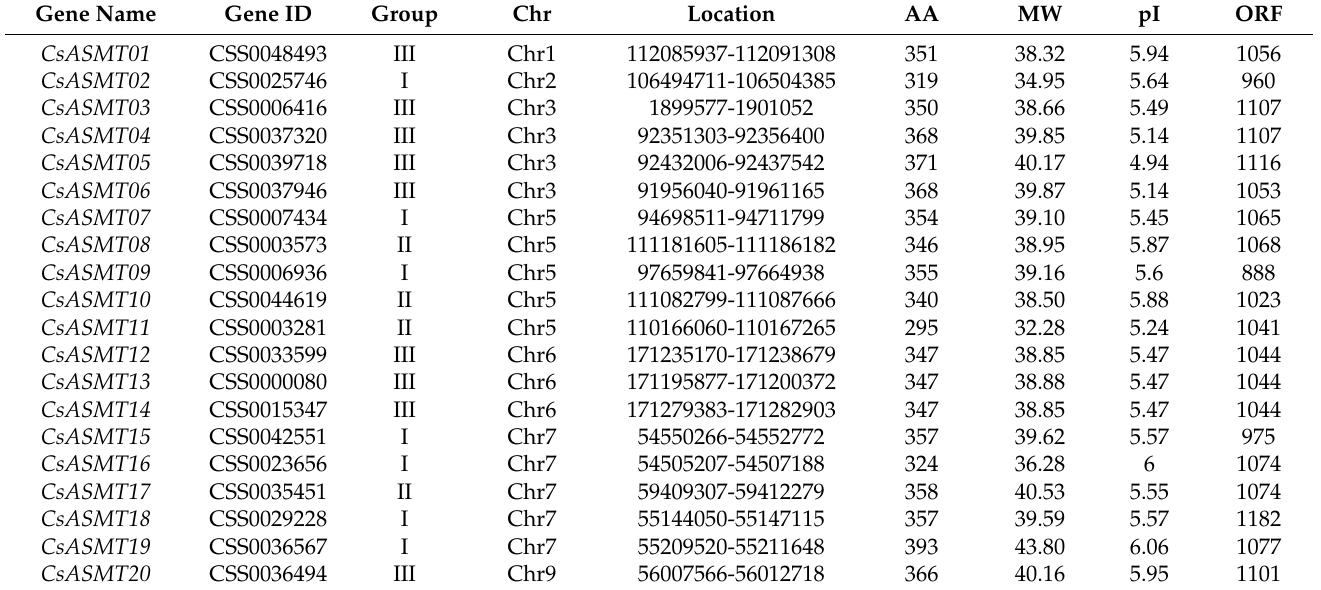
Table 1. Physical and chemical properties of ASMT proteins in C. sinensis